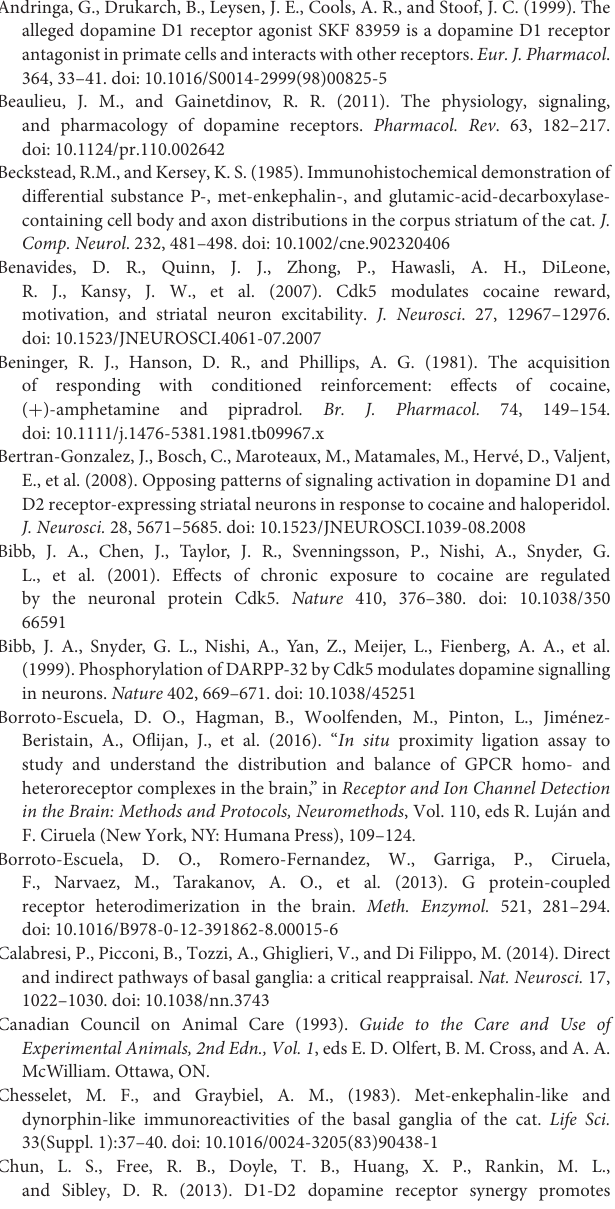
Supplementary Figure 2 | Specificity of PLA: use of TAT-D1 peptide. Supplementary Figure 3 | Z-stack PLA signal between D1R and D2R in rat NAc. Supplementary Figure 4 | PLA signal between D1R and D2R in monkey NAc.